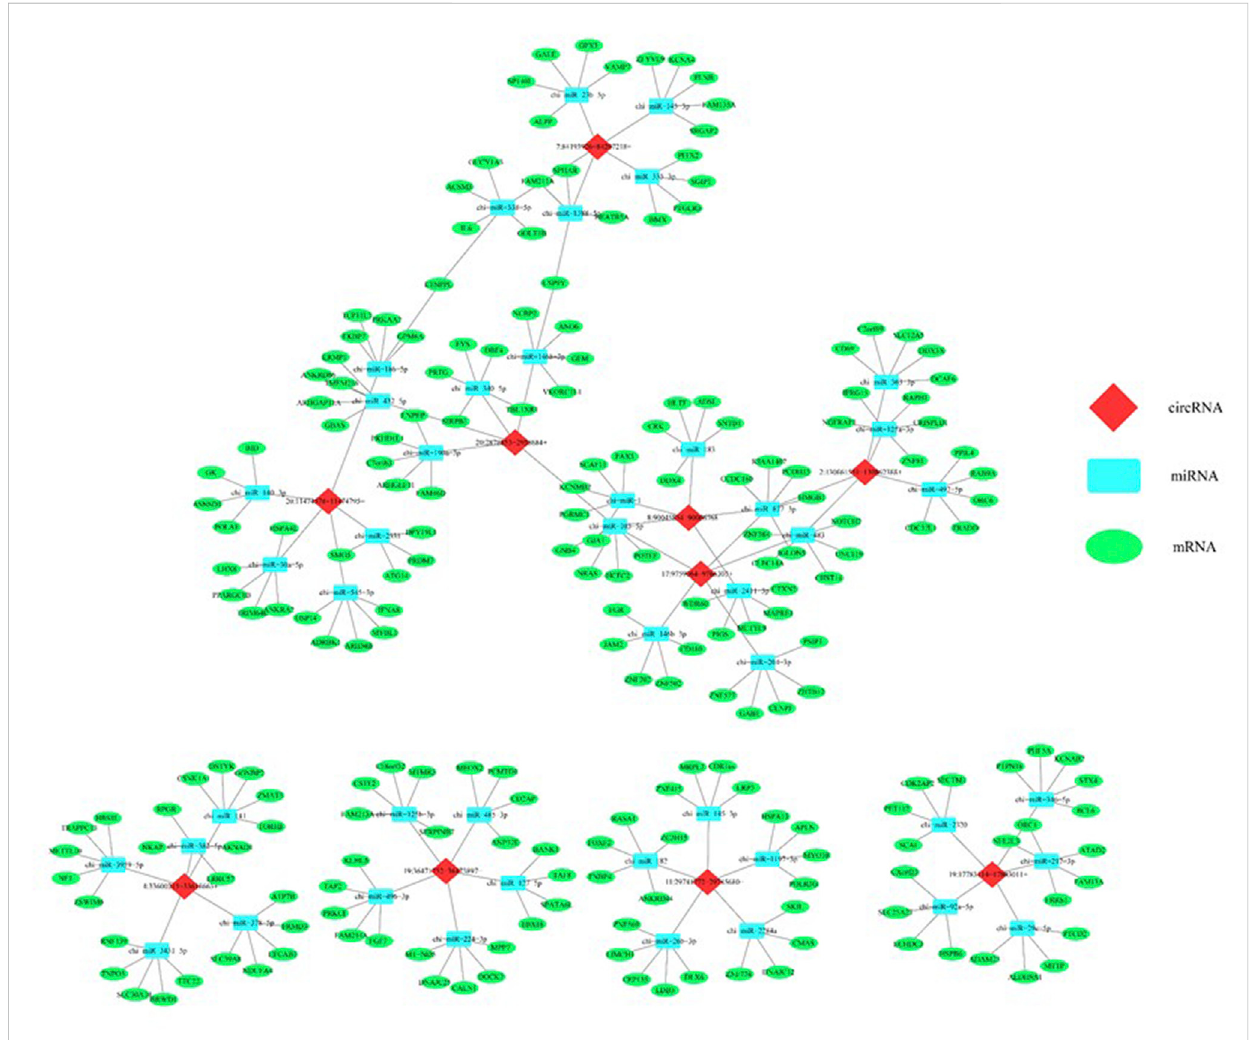
FIGURE 10 In silico analysis predicted a regulatory network consisted of circRNAs, miRNAs, and mRNAs that potentially regulates the epigenetic toxicity in caprine fetal fi broblastcells (CFFCs)inducedby thechronic exposure to theGO-AgNPs. Each ofthetop fi vecircRNAsrelated to fi vemiRNAs and mRNAs were selected to construct the